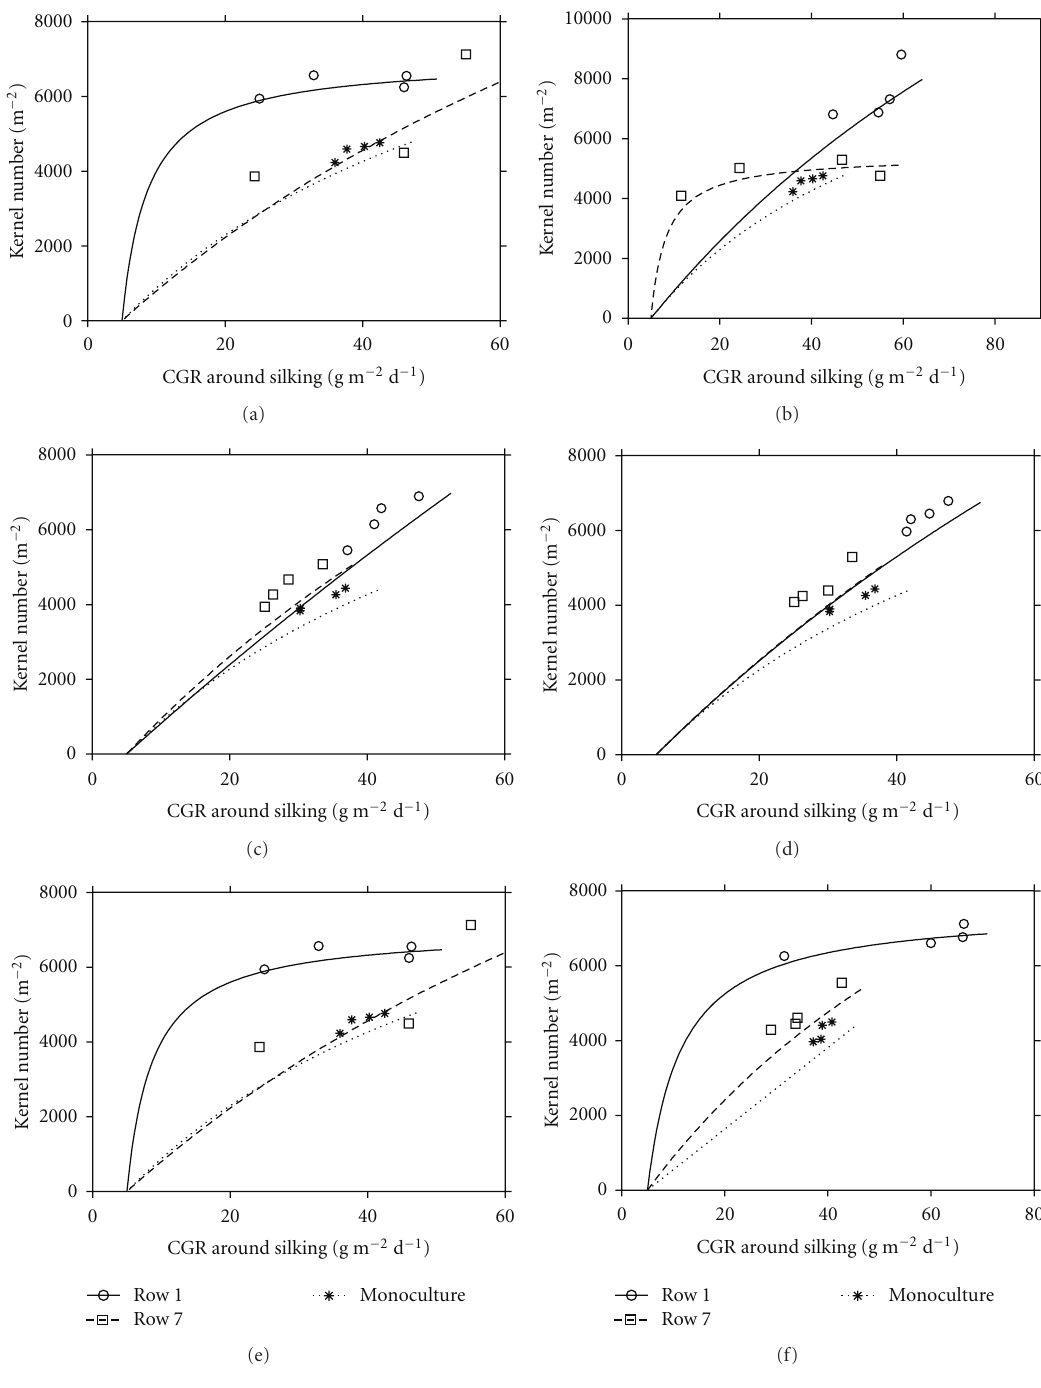
Figure 6: Number of corn grains per unit area in relation to crop growth rate around silking in the monoculture and in the strips 1 (border) and 7 (center) in corn-soybeans MG III strips, during C1 (a), C2 (c), and C3 (e), and of the corn-soybeans MG V strips, in C1 (b), C2 (d) and C3